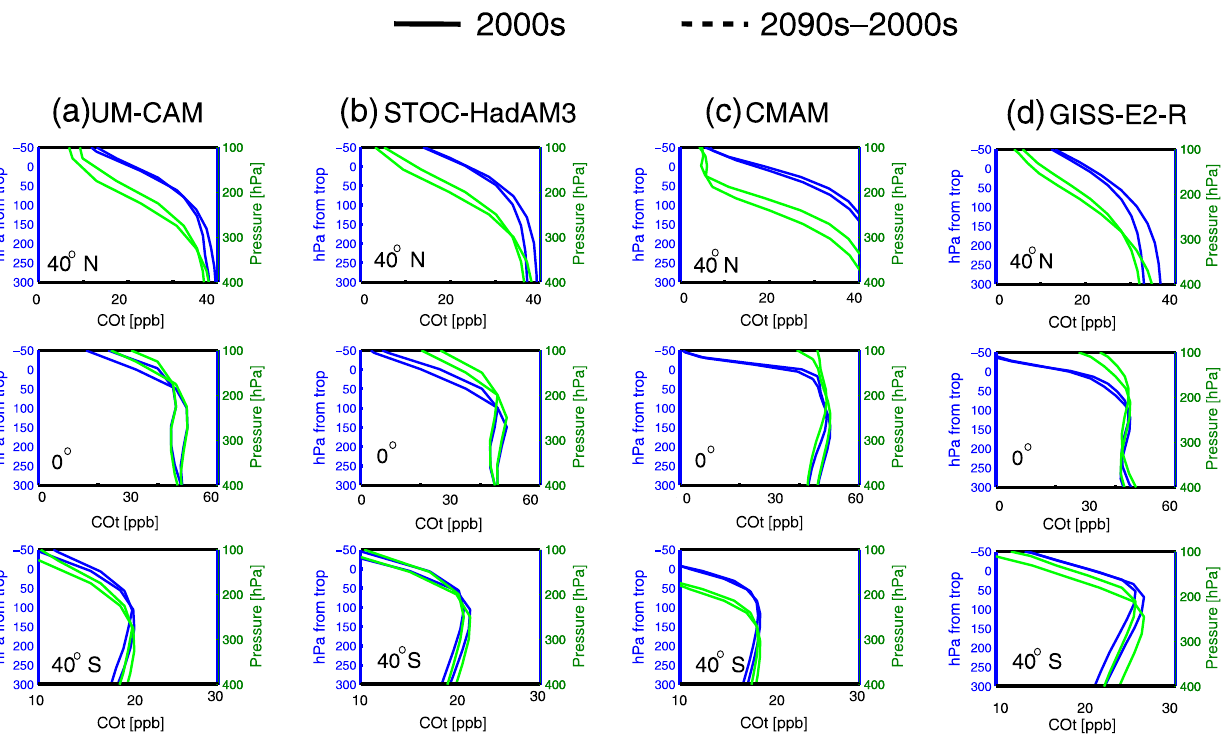
Figure 11. CO-tracer (COt) mixing ratio annual-average profiles (ppb) averaged over various latitude bands (40 ◦ N, 0, 40 ◦ S) for the 2000s (present day) and 2090–2099 (RCP 8.5) for (a) UM-CAM, (b) STOC-HadAM3, (c) CMAM, and (d) GISS-E2-R plotted against altitude in pressure units (hPa) (green) and with distance from the tropopause for the respective time period